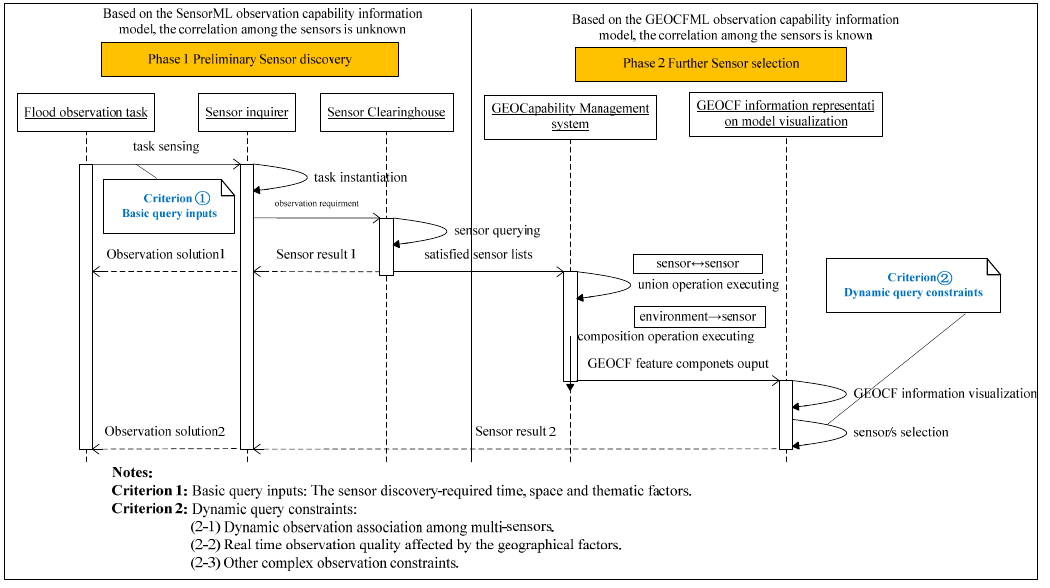
Figure 8. UML sequence diagram showing sensor discovery with the GEOCF information representation model.